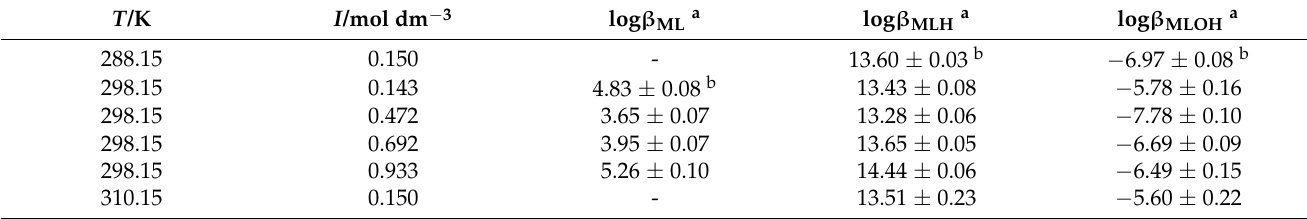
Table 4. Experimental formation constants of the Ca 2+ /Dop − species in NaCl aqueous solutions.